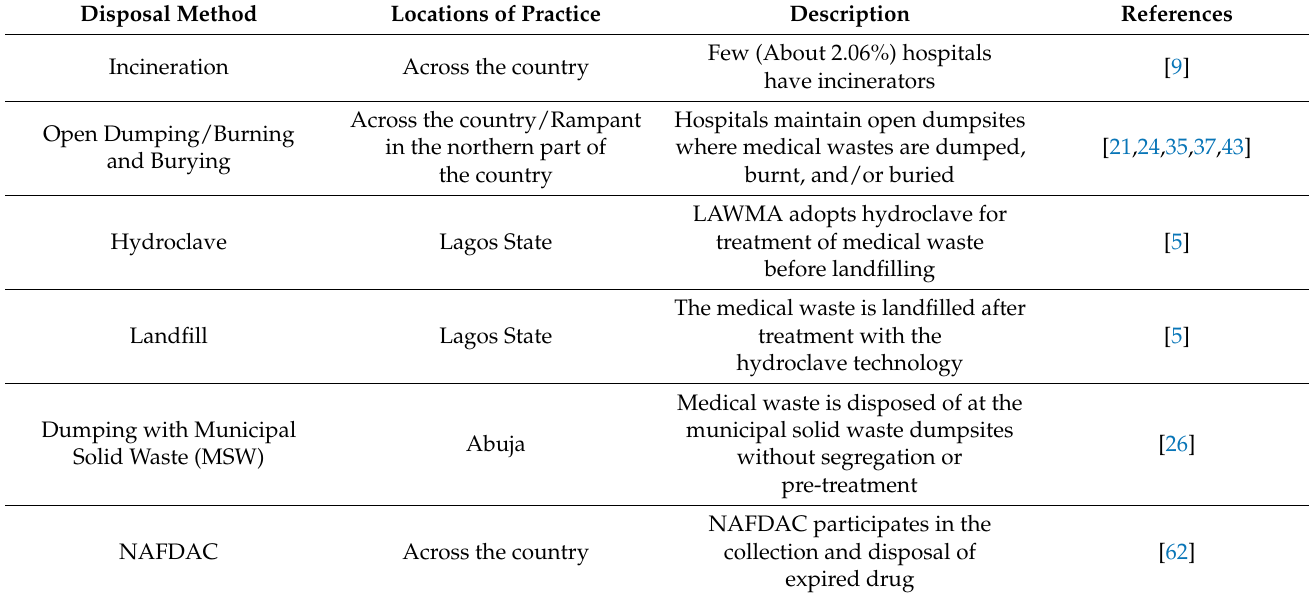
Table 2. Methods of Disposal and Treatment of Healthcare Waste in